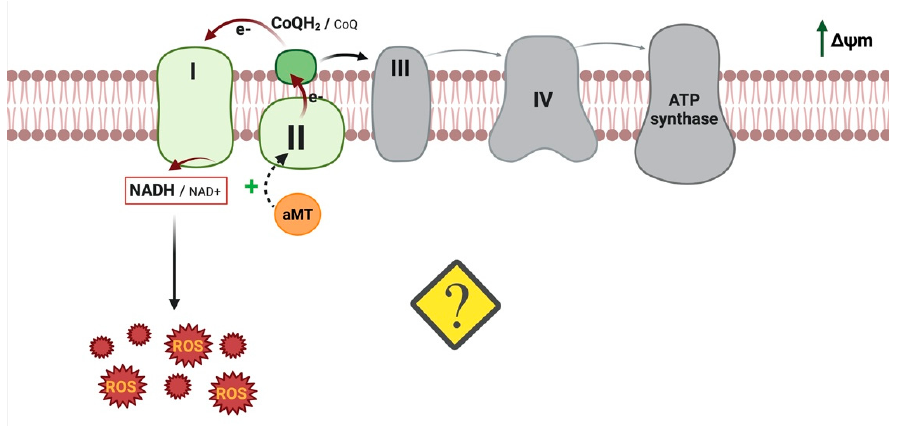
Figure 3. Possible mechanisms of action of melatonin to induce ROS production via RET. In our view, melatonin increases mitochondrial CII activity, membrane potential, and CoQH2/CoQ, leading to RET-ROS production. Image created using BioRender.com (accessed on 18 of august 2022).